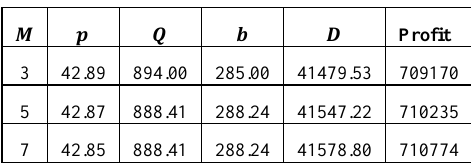
Table 3. Effect of changing permissible delay in paymentson the selling price, optimal order level, backorder level, and retailer’s expected profit